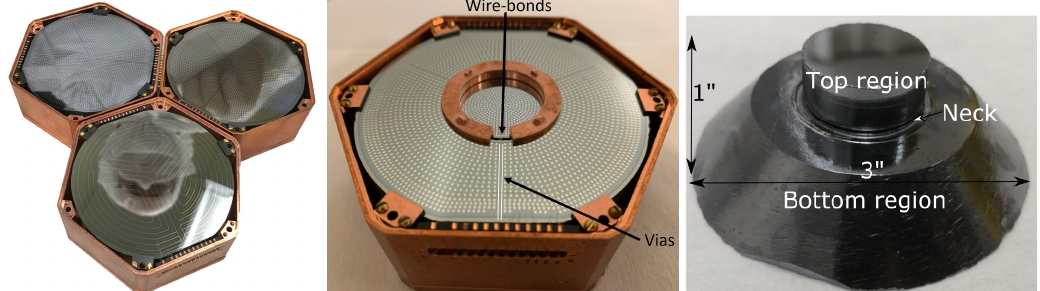
Figure 4: MINER detector technology: (left) SuperCDMS detector technologies in use in the form of iZIP and HV detectors, (center) New MINER technology that pro- vides significantly improved background reduction, (right) and